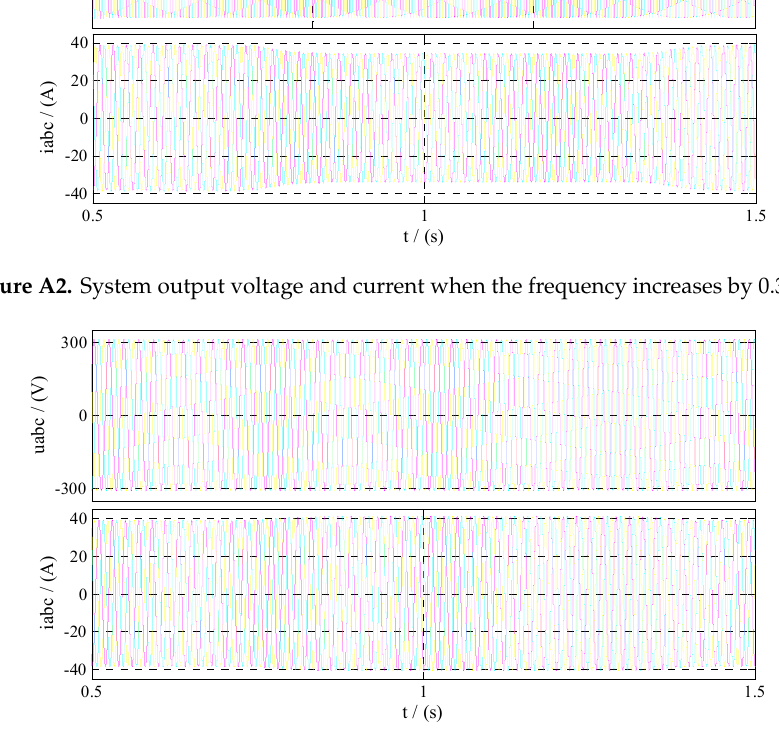
Figure A3. System output voltage and current when the frequency decreases by 0.1 Hz.